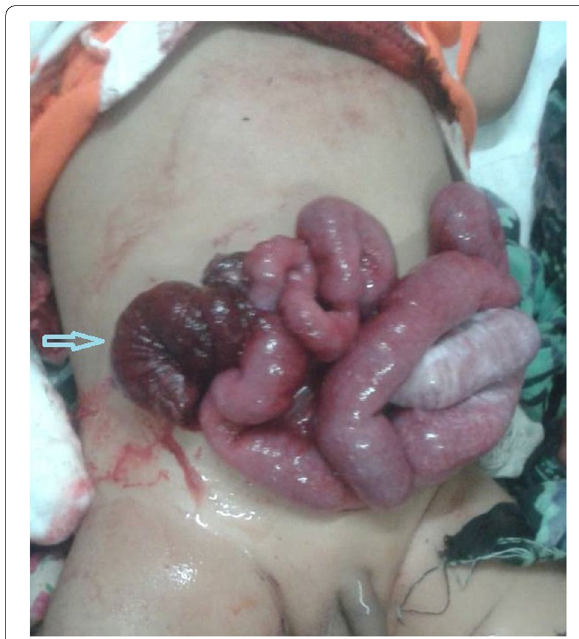
Fig. 1 Clinical photograph showing the evisceration of the small gut with reverse intussusception (arrow)